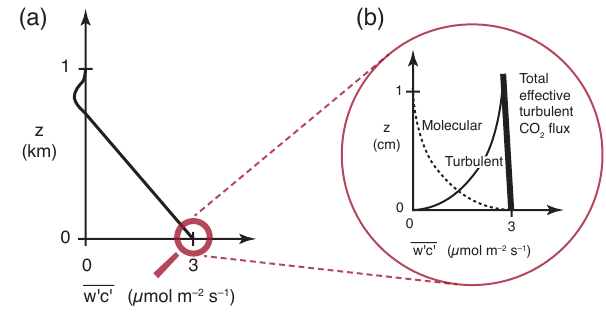
Figure 3. Idealized vertical profile of CO 2 flux (a) during daytime under convective, well-mixed atmospheric conditions over bare or- ganic soil with a respiration flux of 3µmolm − 2 s − 1 at the ground surface and comparatively small entrainment flux at the top of the atmospheric boundary layer (at z around 0.8–1km). (b) The zoom indicates how the molecular flux from the soil is incorporated in the turbulent flux near the ground surface to yield total effective turbu- lent CO 2 flux. Modified and adapted to CO 2 after Stull (1988) with kind permission of Springer Science+Business